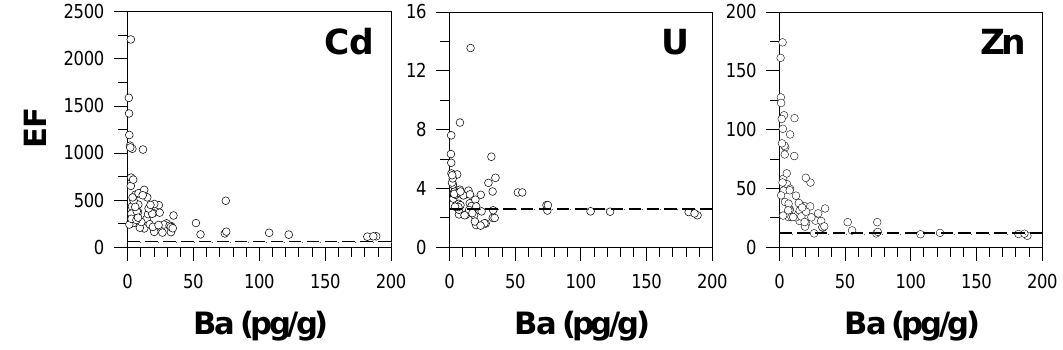
Figure 3. Changes in crustal enrichment factors (EF) of Cd, U, and Zn as a function of Ba concentrations. Horizontal dashed lines represent the mean Holocene natural EF values for each element (see text).